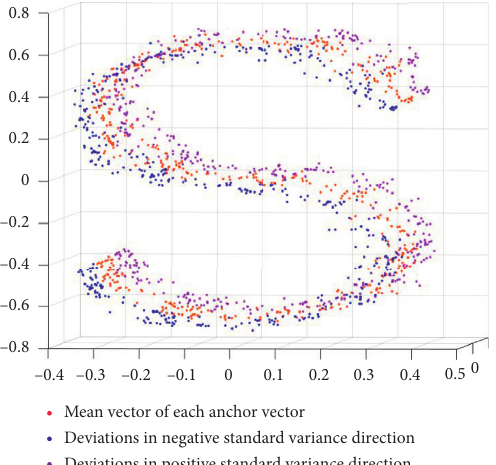
Figure 12: The mean vectors and deviations because of distribution parameters at each anchor vector